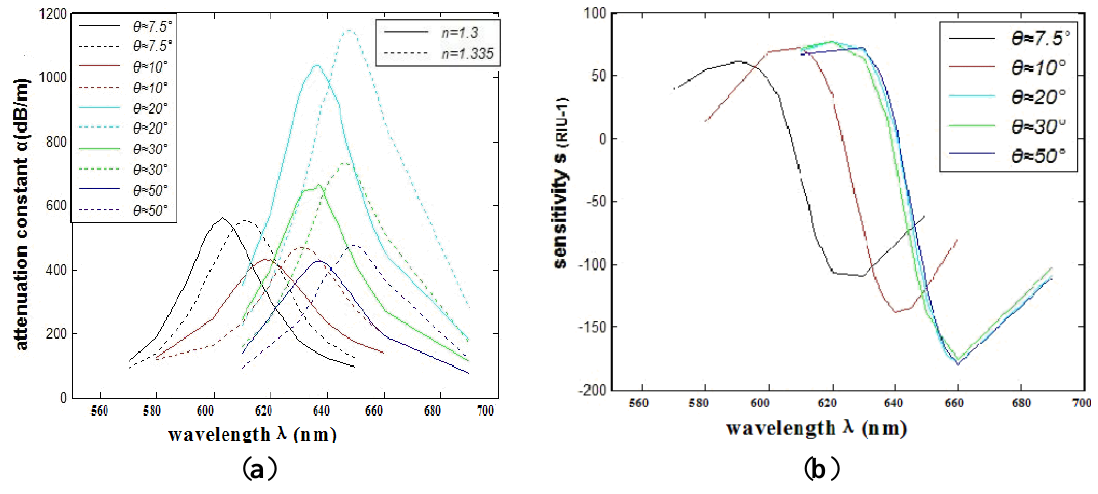
Figure 4. ( a ) The comparison of attenuation constant of the fundamental mode of different relative distances between two silver nanowires; ( b ) The comparison of intensity detection sensitivity (RIU −1 ) curves.